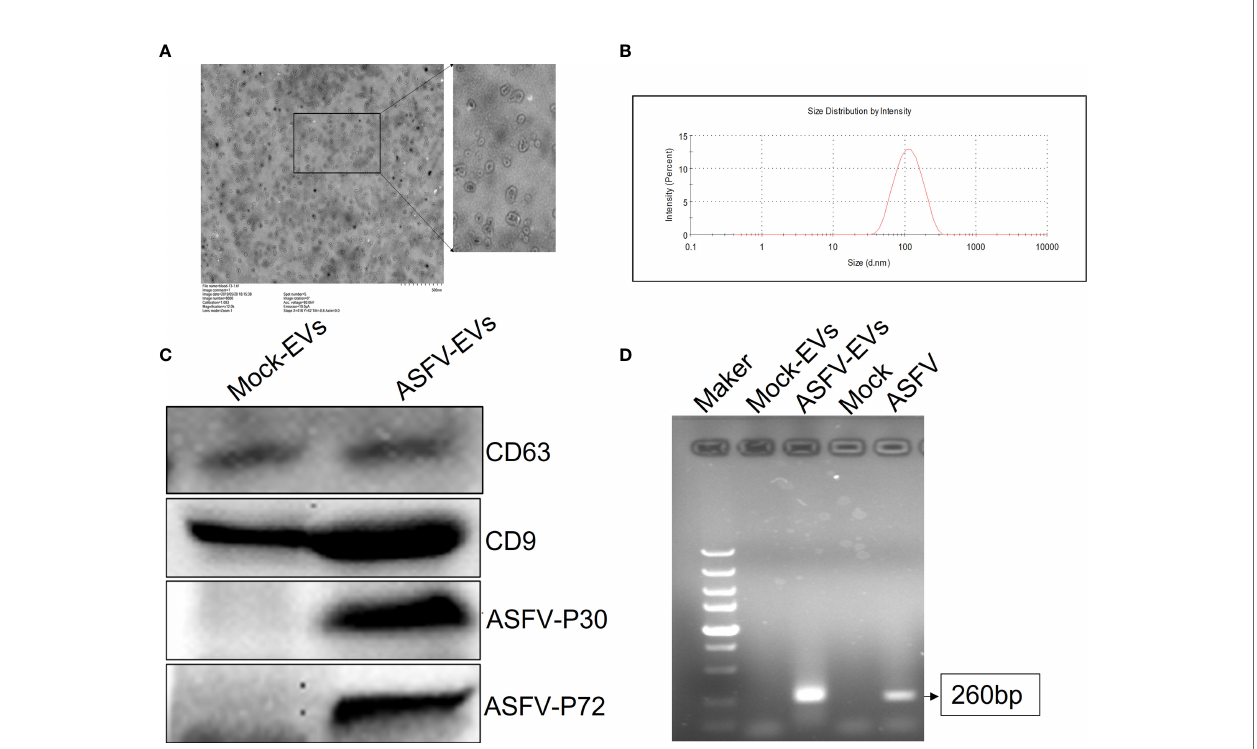
FIGURE 1 | Plasma exocytosis maker protein and ASFV protein contained in extracellular vesicles were identi fi ed. (A) The extracted extracellular vesicles were stained with phosphotungstic acid and observed with a transmission electron microscope. (B) The puri fi ed plasma extracellular vesicles samples were diluted 1:1000 in PBS containing 0.05% Tween-20 to a total volume of 1.0 mL. The test was repeated 3 times with standard settings (refractive index = 1.331, viscosity = 0.89, temperature = 25°C). Each sample was analyzed 5 times, and the average value was taken. (C) Extracellular vesicles CD63 and CD9, ASFV P30 and P72 proteins were identi fi ed in extracellular vesicles by WB analysis. (D) PCR identi fi cation results of ASFV p72 geneMOCK-EVs represent extracellular vesicles extracted from ASFV-negative pig plasma, ASFV-EVs represent extracellular vesicles extracted from ASFV-positive pig plasma, Mock represent PBS negative control, and ASFV represent ASFV-positive cell culture